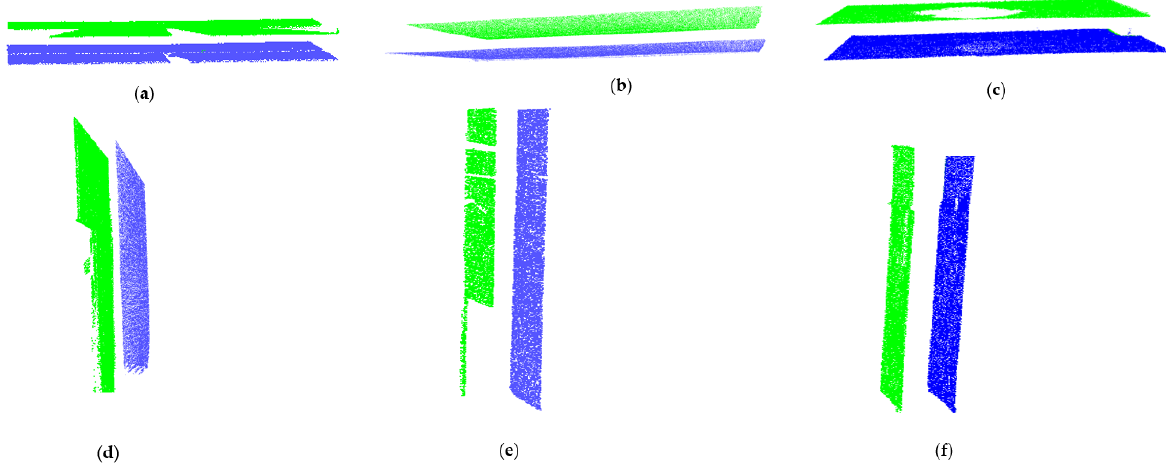
Figure 16. Pairs of generated principle planar patches: ( a – c ) horizontal principal patches; ( d – f ) vertical principal patches.